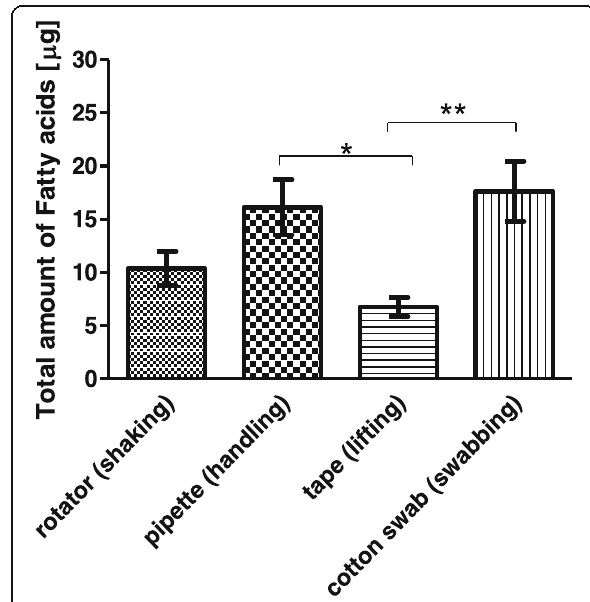
Fig. 10 Total quantity of fatty acids by using different treatment methods ( μ g of total fatty acid). Data are represented as means ± SEM. The p value is < 0.0295 ( n = 8, eight donors). The two asterisks indicate 0.0001 ≤ p <